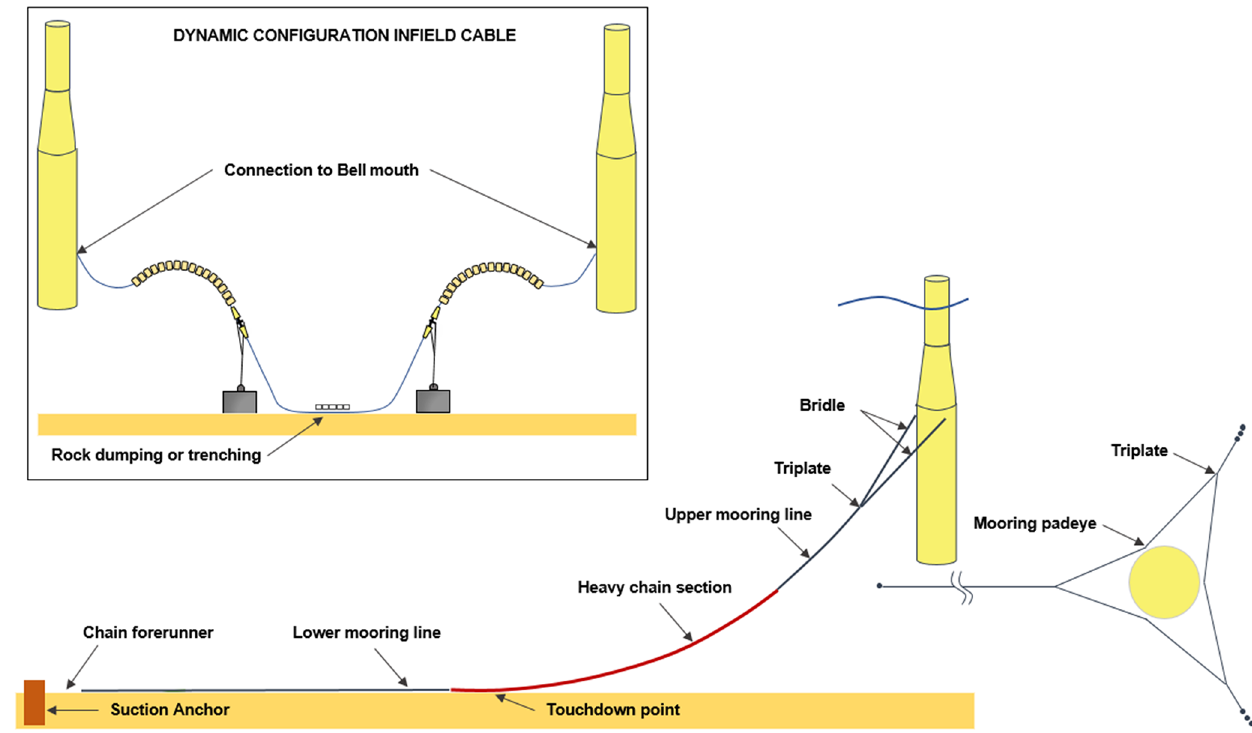
Figure 2. Layout of turbine substructures, mooring lines, suction anchors and infield cables. Figure based on schematic provided by